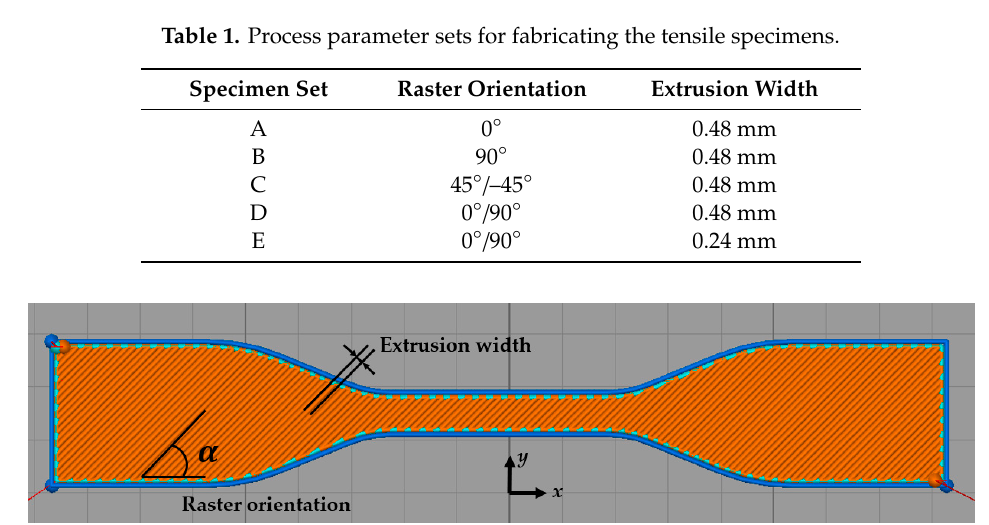
Figure1. AnillustrationoftherasterangleandextrusionwidthfromSimplify3Dtoolpaths. Thebuilding Figure 1. An illustration of the raster angle and extrusion width from Simplify3D toolpaths. The direction is along the z building direction is along the z -axis.